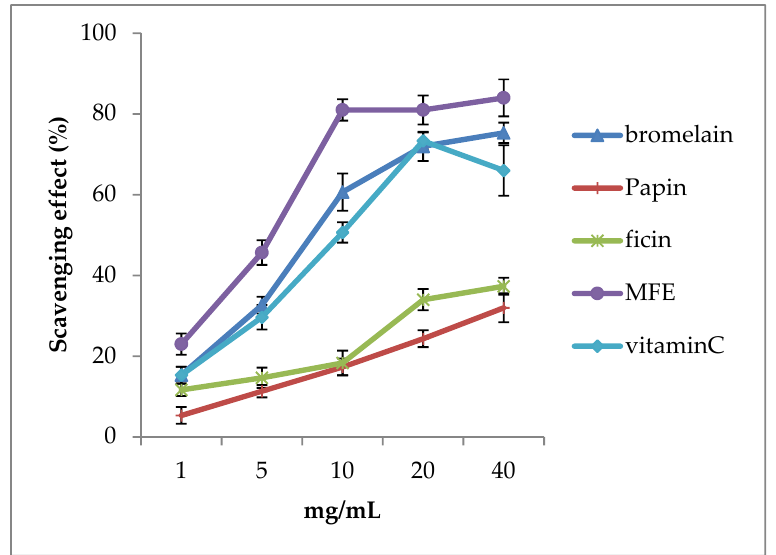
Figure 3. The free radical scavenging activity of various fruit enzymes, including vitamins C (placebo) and mixed fruit enzymes (MFEs). We found that the antioxidant ability of MFEs and bromelain is higher than in vitamin C. It was also revealed that MFEs (purple color line) have significantly higher scavenging activities than vitamin C (sky-blue color line) in all concentrations (1, 5, 10, 20, and 40 μ g/mL) ( p < 0.05). Therefore, we suggested that MFEs enhance higher antioxidant abilities to resist oxidative stress compared with vitamin C. Thus, MFEs could help patients with ocular floaters and intraocular hemorrhage–induced floaters cut and absorb in clinics.